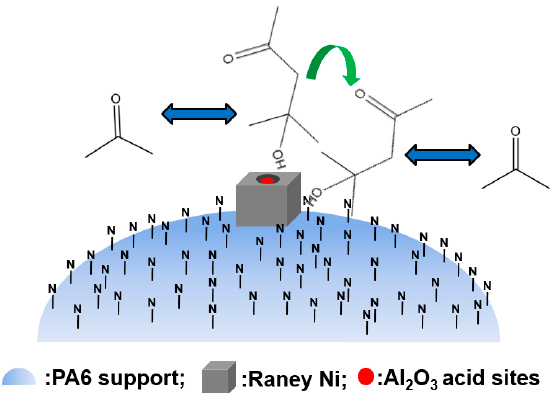
Figure 7. Schematic representation of elimination of MIBC over Raney Ni/PA catalyst. Reproduced from [18] with permission from Jiang H., Sci. China Chem.; published by Springer, 2016.